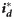
Active current references id* of the inverter control system under grid disturbance.